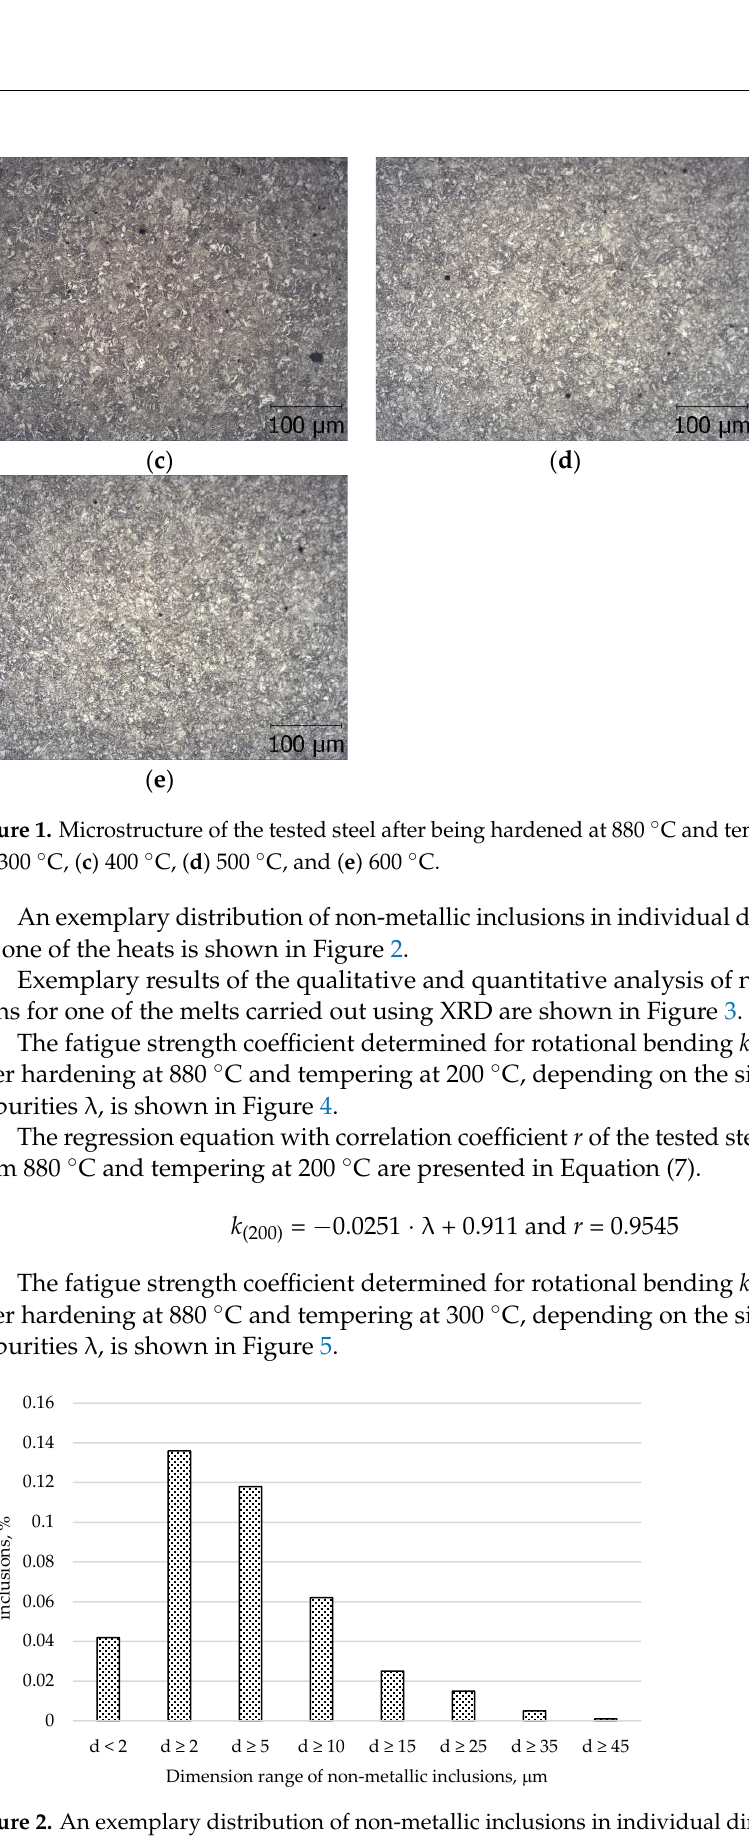
Figure 2. An exemplary distribution of non-metallic inclusions in individual dimensional ranges in the tested steel. Exemplary results of the qualitative and quantitative analysis of non-metallic inclu- sions for one of the melts carried out using XRD are shown in Figure 3.